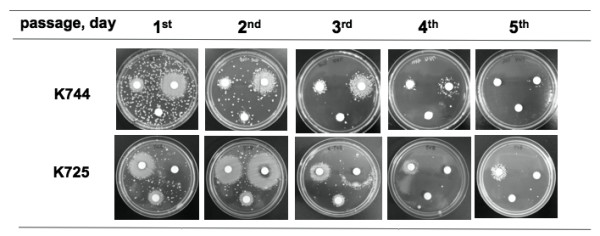
Phase-out of the BIVR phenomenon. BIVR cells were transferred to antibiotic-free MH agar and the plate was incubated at 37°C for 24 h. Cell suspensions from the plates were inoculated again on antibiotic-free MH agar and incubated for 24 h at 37°C. This serial transfer and culture was continued for 5 consecutive days. The culture was subjected to the BIVR test every day. Only a representative strain from the laboratory stock BIVR, K744 and freshly isolated clinical strains, K725, is presented. 1st to 5th represents the cycle of passage in the antibiotic-free medium.